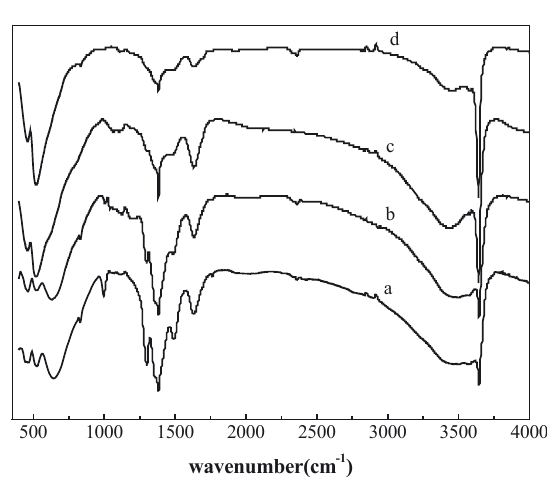
obtained at different 2